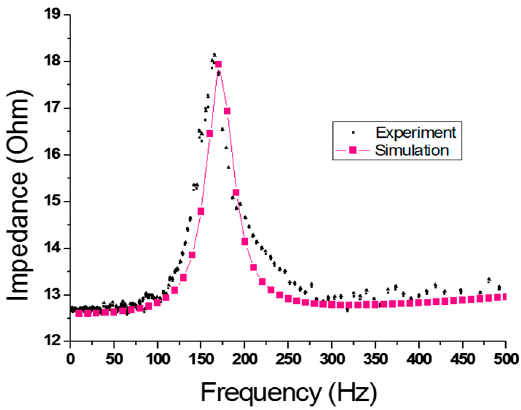
Figure 11. Impedance comparison of experiment and simulation.